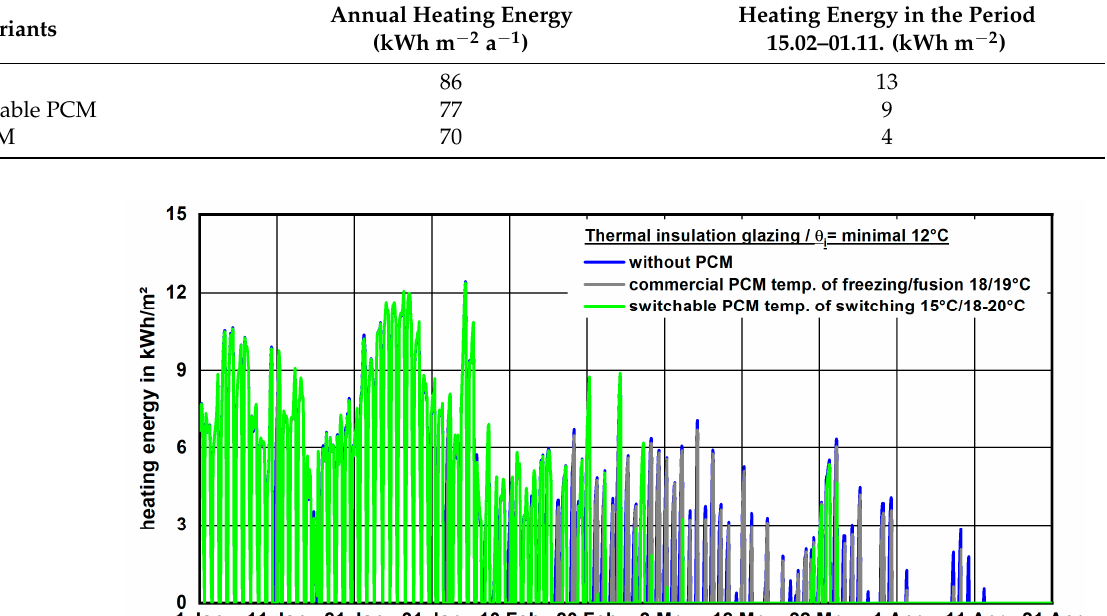
Table 3. Required heating energy to achieve a minimum temperature of 12 ◦ C in the greenhouse.